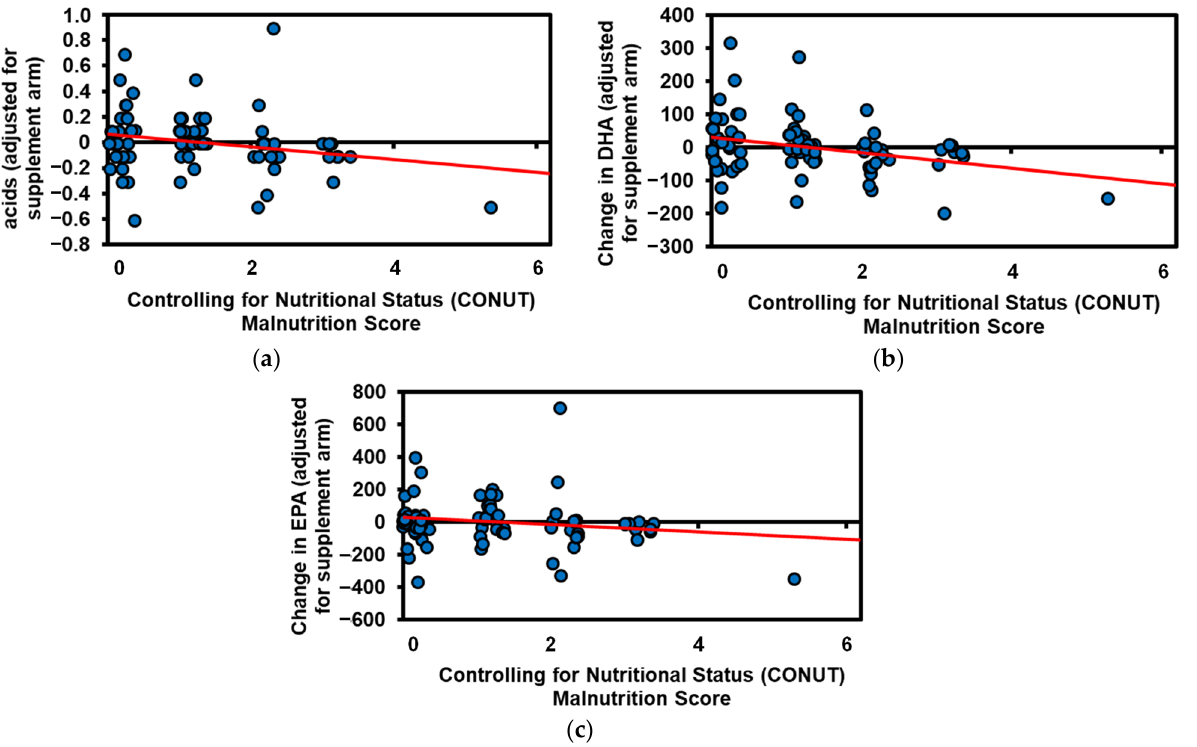
Figure 2. Associations between baseline Controlling for Nutritional Status (CONUT) score and change in serum ( a ) total omega-3, ( b ) docosahexaenoic acid (DHA), and ( c ) eicosapentaenoic acid